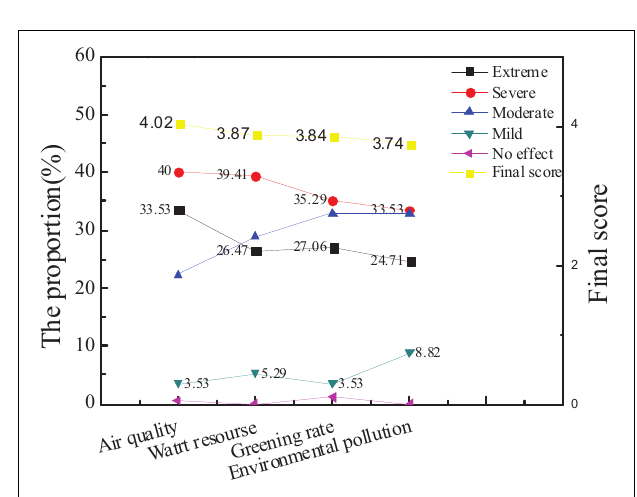
FIGURE 12 | Attention and scores of the audiences on influencing factors of city environmental